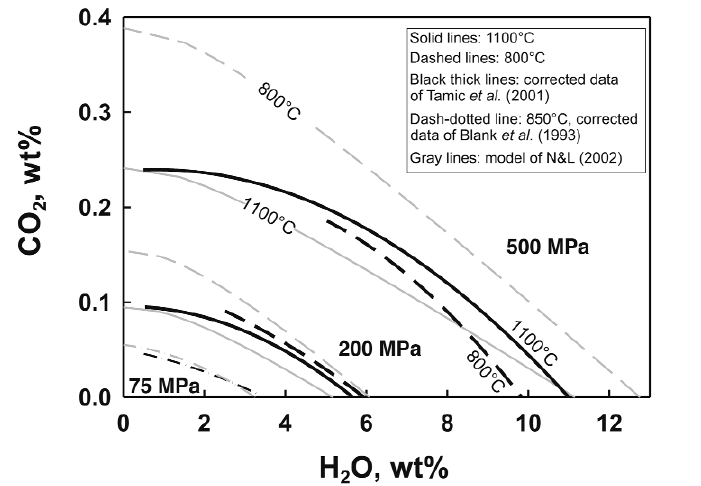
Fig. 2. Temperature dependence of H 2 O and CO 2 solubility in rhyolitic melt at 200 and 500 MPa after Tamic et al . (2001). The data of Blank et al . (1993) are shown for comparison. All data have been corrected using the IR absorption coefficient for molecular CO 2 of 1216 l·mol − 1 ·cm − 1 after Behrens et al . (2004a). Gray lines are the calculated volatile solubilities by the model of Newman and Lowenstern (2002). Note the opposite temperature effects observed in experimental and modeled solubility curves at 500 MPa. The predictions of the empirical model of Liu et al . (2004) coincide with the fits of experimental data and not presented in the diagram (for de- tail see fig. 6 in the work of Liu et al .,